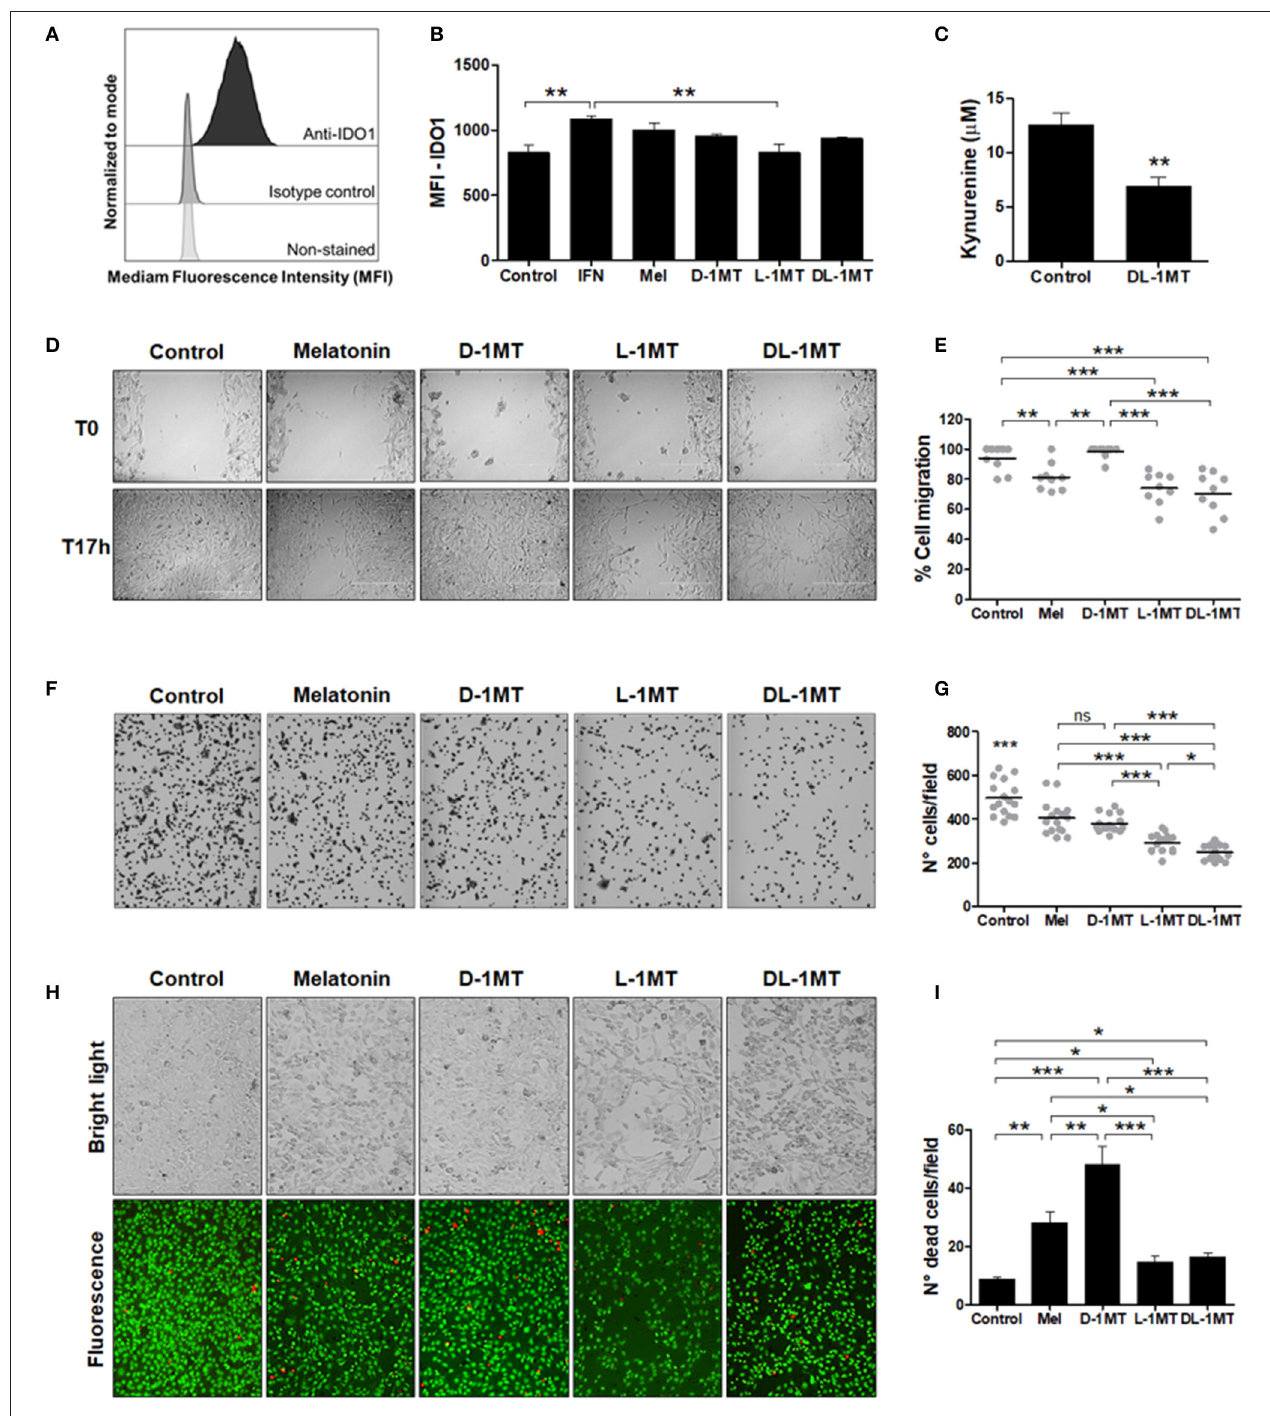
FIGURE 1 | IDO1 expression and the effects of melatonin and IDO inhibitors on TC-1 cells migration and adhesion. (A) IDO1 expression measured with anti-IDO1 antibody staining and flow cytometry analysis. Isotype control and non-stained cells were used as negative controls for IDO1 expression and cellular auto-fluorescence, respectively. (B) Median fluorescence intensity (MFI) of IDO1 expression in TC-1 cells measured by flow cytometry. Cells were treated with IFN- γ (50 u/mL), or melatonin (1mM), or 1MT compounds (D-1MT, L-1MT, DL-1MT) (1mM) for 24h. Cells in culture media without immunomodulators (vehicle) are shown as reference controls. Data representative of two independent experiments performed in triplicates. (C) Ehrlich test performed to measure kynurenine concentrations in TC-1 cell supernatants after treatment with DL-1MT (1mM) for 24h. Data representative of two independent experiments performed in triplicates. Significance